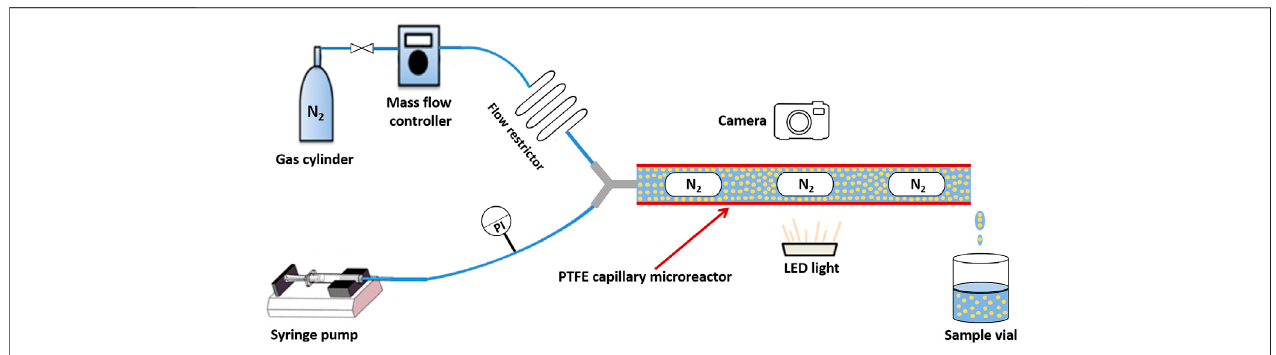
TABLE 1 | Properties of the prepared nano fl uids and base fl uids at 22 ° C. Fluid a Density ( ρ ) kg/m 3 Surface Nano fl uid ( φ (cid:1) 0.05